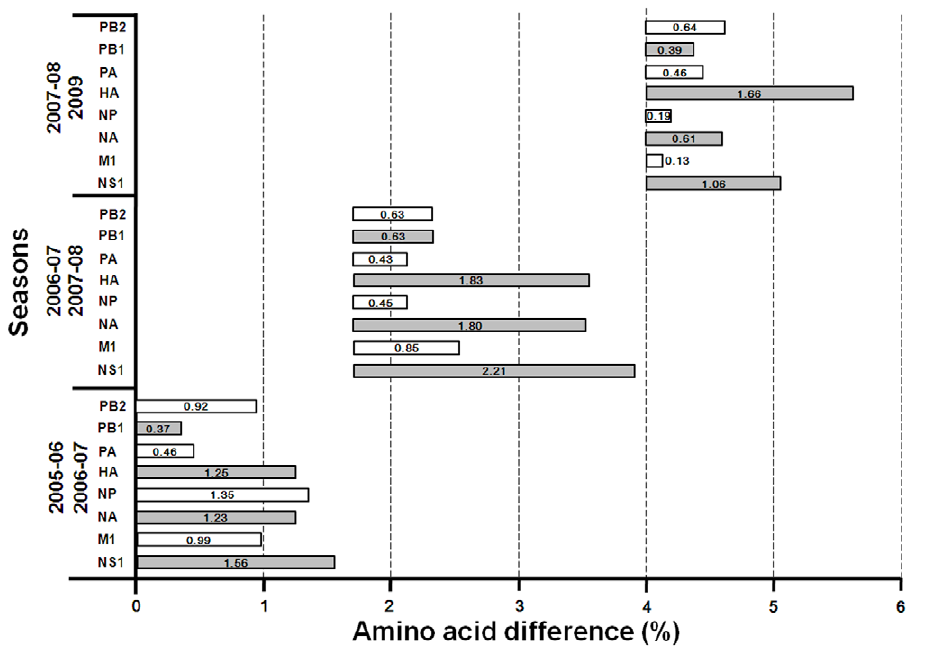
Figure 5. The trend of H3N2 protein distance. Distance means were computed as the arithmetic mean of all pair wise distances between two seasons.